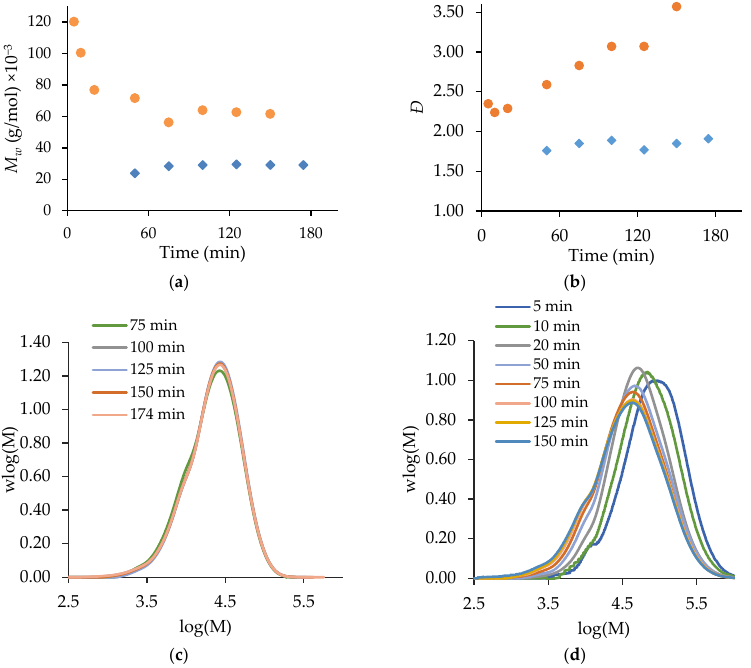
Figure 6. A comparison of semi-batch ( (cid:117) ) and batch ( • ) MA/t-BuAAm copolymerization with 0.50 mole fraction of MA and a final monomer/polymer content of 20 wt% in 75/25 EtOH/H 2 O with 1% AIBN at 60 ℃ : ( a ) M w vs. time, ( b ) Ð vs. time, ( c ) MWD vs. time for semi-batch, ( d ) MWD vs. time for batch.